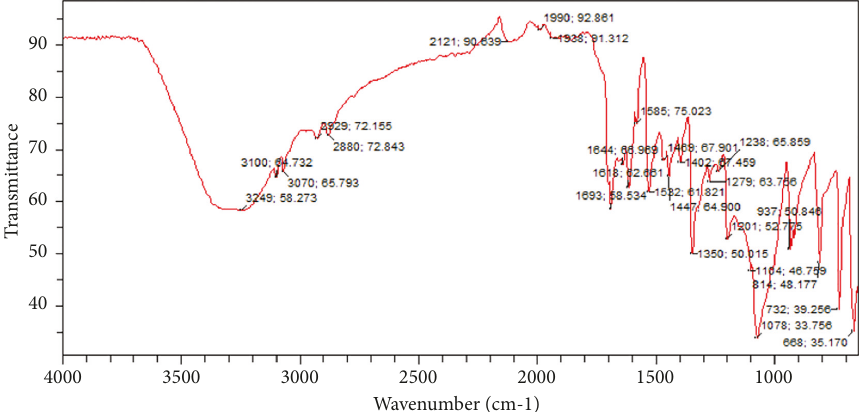
p 0 . 05) different from each other. <